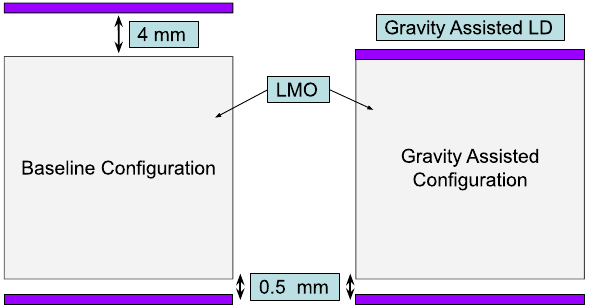
Fig. 3 Schematic view of the 2 LD configurations: the grey squares and the purple strips represent respectively the LMO crystals and the LDs.Left:“baseline”configurationwithLDsspaced0.5and4mmfrom the bottom and top of the crystal respectively. Right: “gravity-assisted” configuration with LDs spaced 0.5mm on bottom and leaned on top of the